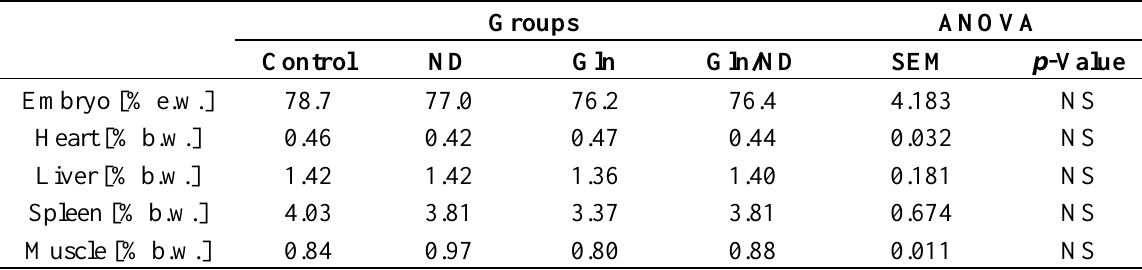
Table 1. Average weight of chicken embryos, organs, and pectoral muscles in the control group and groups treated with nanoparticles of diamond (ND), L -glutamine (Gln), and bio-complex of Gln with ND (Gln/ND), n = 40/group. Groups ANOVA Control ND Gln Gln/ND SEM p -Value Embryo [% e.w.] 78.7 77.0 76.2 76.4 4.183 NS Heart [% b.w.] 0.46 0.42 0.47 0.44 0.032 NS Liver [% b.w.] 1.42 1.42 1.36 1.40 0.181 NS Spleen [% b.w.] 4.03 3.81 3.37 3.81 0.674 NS Muscle [% b.w.] 0.84 0.97 0.80 0.88 0.011